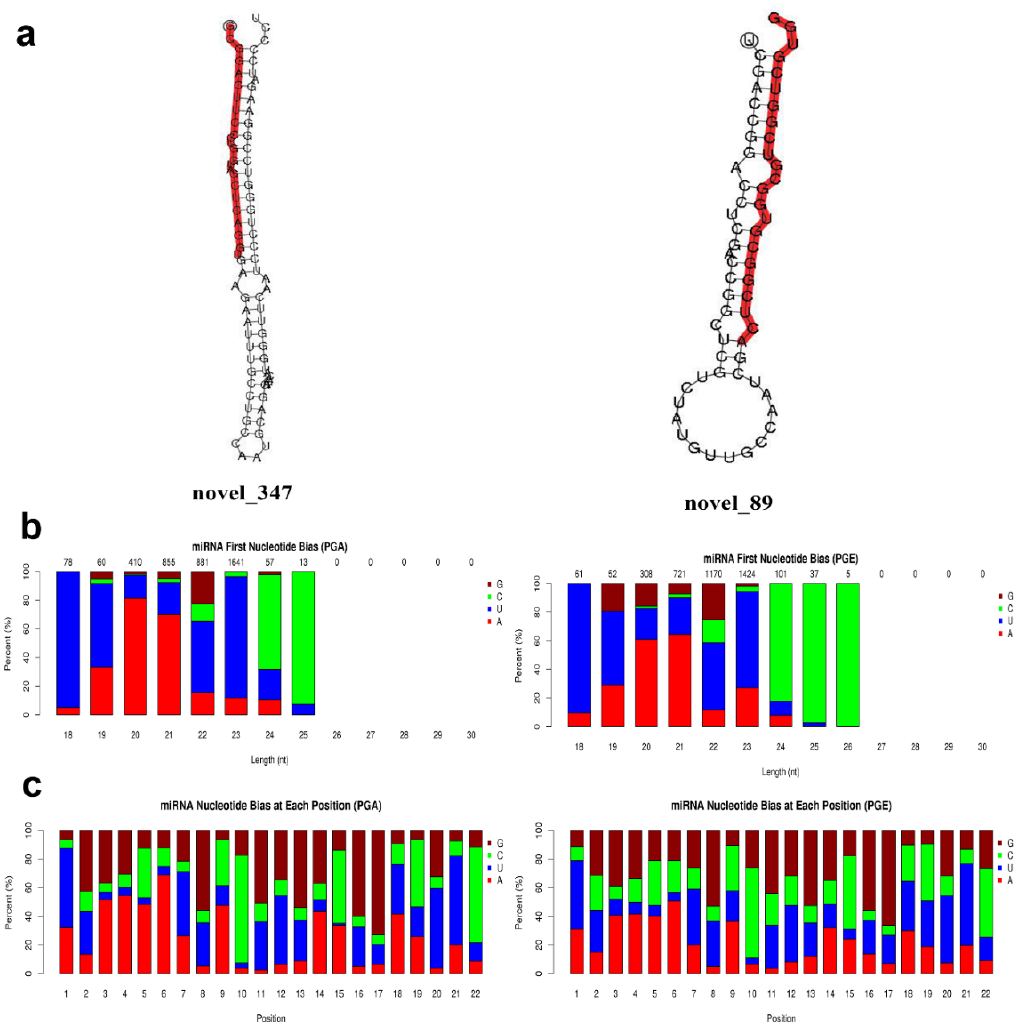
Figure 4. Novel miRNAs prediction and analysis. ( A ) Partially predicted novel miRNA secondary structure. The whole sequence is a precursor miRNA and red highlight is a mature sequence. ( B ) First base distribution of novel miRNAs 18~30 nt in length: the horizontal axis is the length of the miRNA, and the vertical axis is the ratio of A/U/C/G in the first base of the length sRNA (the value above the histogram is the length of the miRNA total number of items). ( C ) Base distribution of 22 nt novel miRNAs: the horizontal axis is the base position of the miRNA, and the vertical axis is the ratio of the bases A/U/C/G of the miRNA at this position.